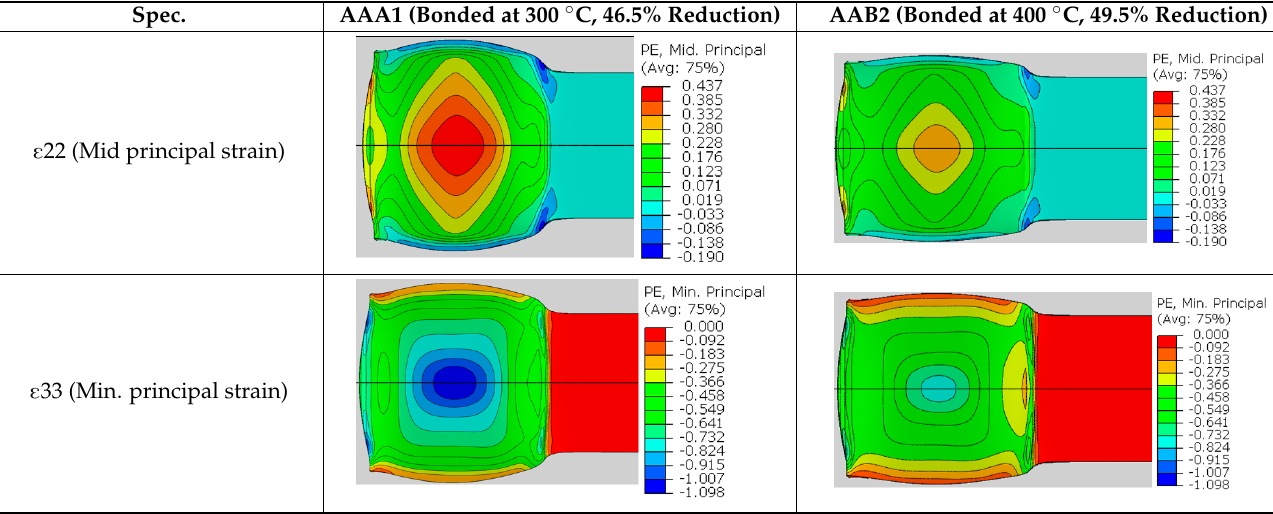
Figure 8. Areas of interest where the different values of bonding quality parameter J where com- puted.